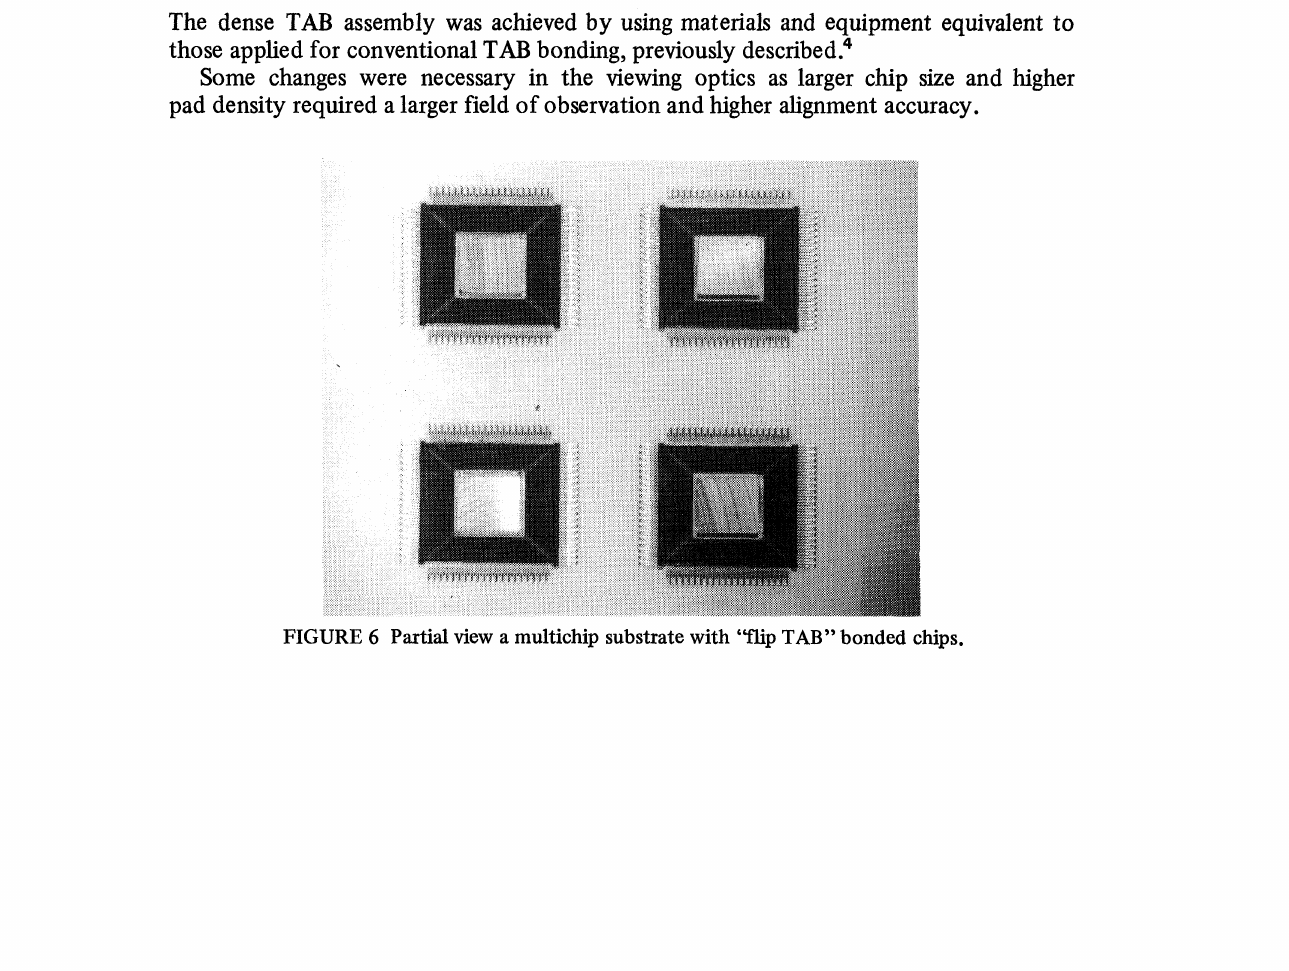
FIGURE 6 Partial view a multichip substrate with ’kqip TAB" bonded